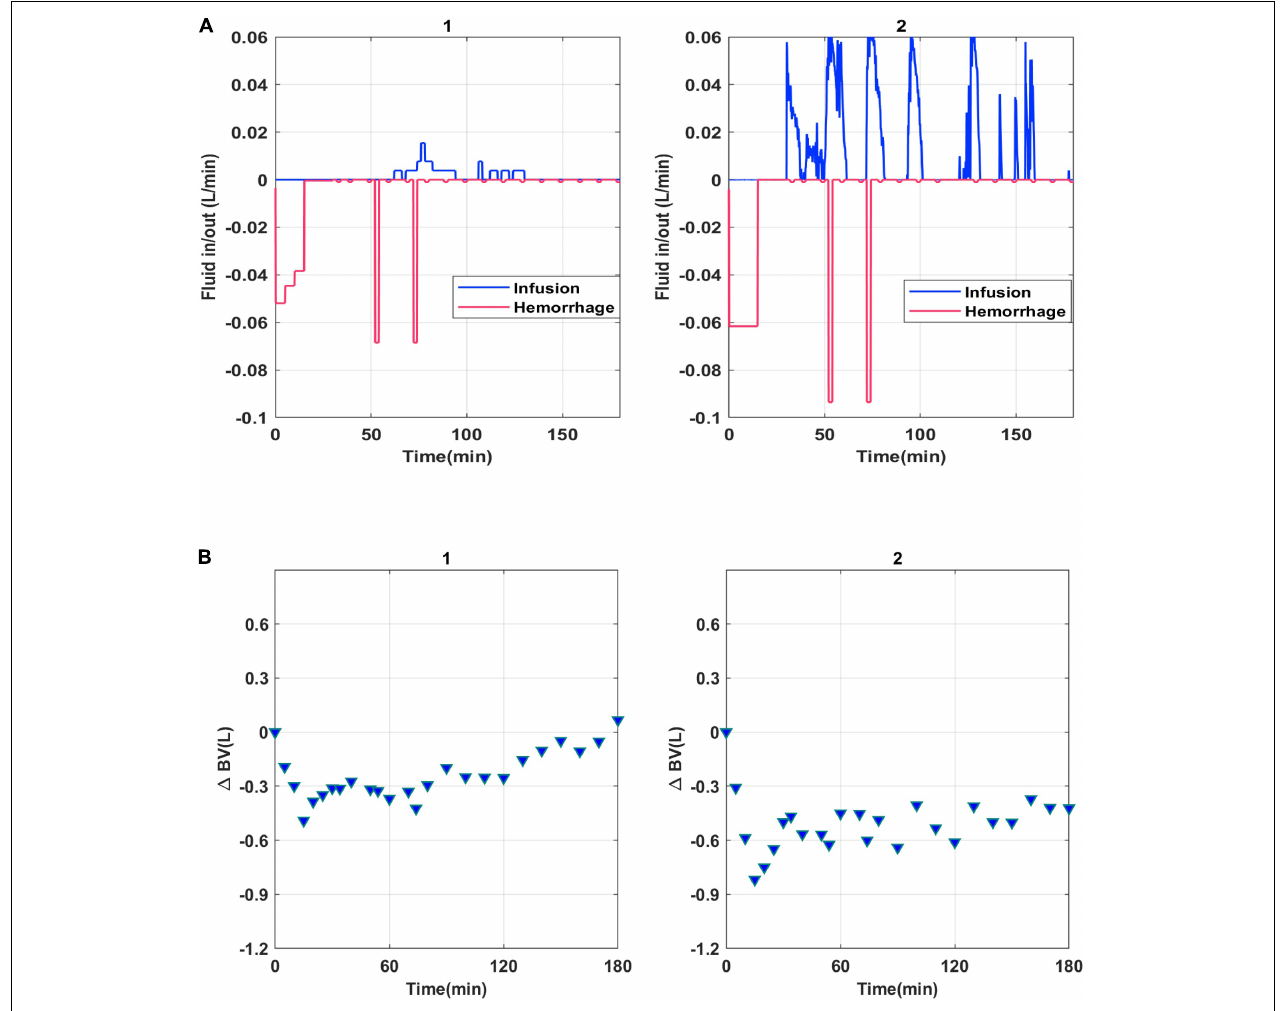
FIGURE 1 | Model fluid input (A) and change in blood volume (B) for subjects 1 and